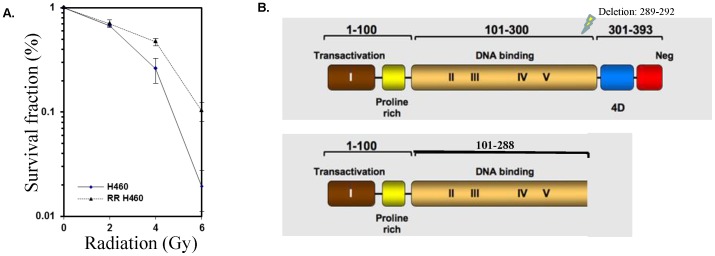
Identification of a novel radiation-induced p53 mutation that confers resistance to subsequent radiotherapy.H460 cells (p53-competent) were exposed to sequentially higher doses of radiation, then incubated at 37°C for 8–10 days. One surviving (radiation-resistant) clone was selected and expanded to create a radiation-resistance H460 cell line (RR-H460). To confirm the effect of novel deletion on cell survival, a second radiation of 6 Gy was applied to cells from the parental and RR lines. A. Radiation resistance was confirmed by clonogenic assay after treatment with 0–6 Gy. A significant (p<0.007) difference in survival between the radiation resistant colony and the parent cell line was noted at doses of 4 or 6 Gy. SF = 0.2. B. Sequencing analysis revealed a novel deletion mutation at the end of the DNA binding domain of p53. Figure modified from the TP53 website (p53.free.fr).